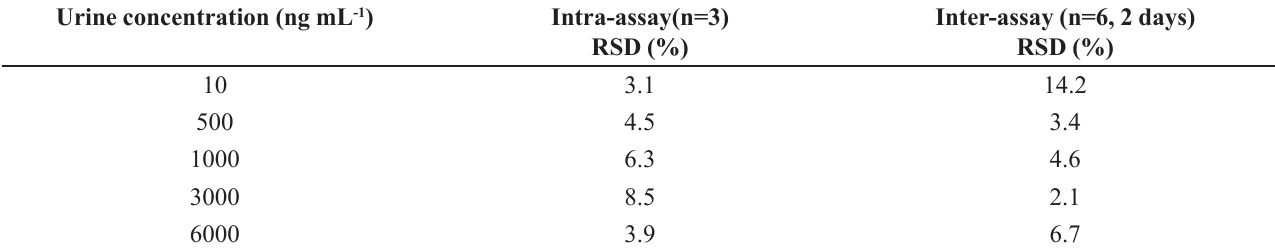
TABLE VI - Intra- and inter-assay precision for the analysis of cotinine in urine, by CG-NPD after ELL. Urine concentration (ng mL -1